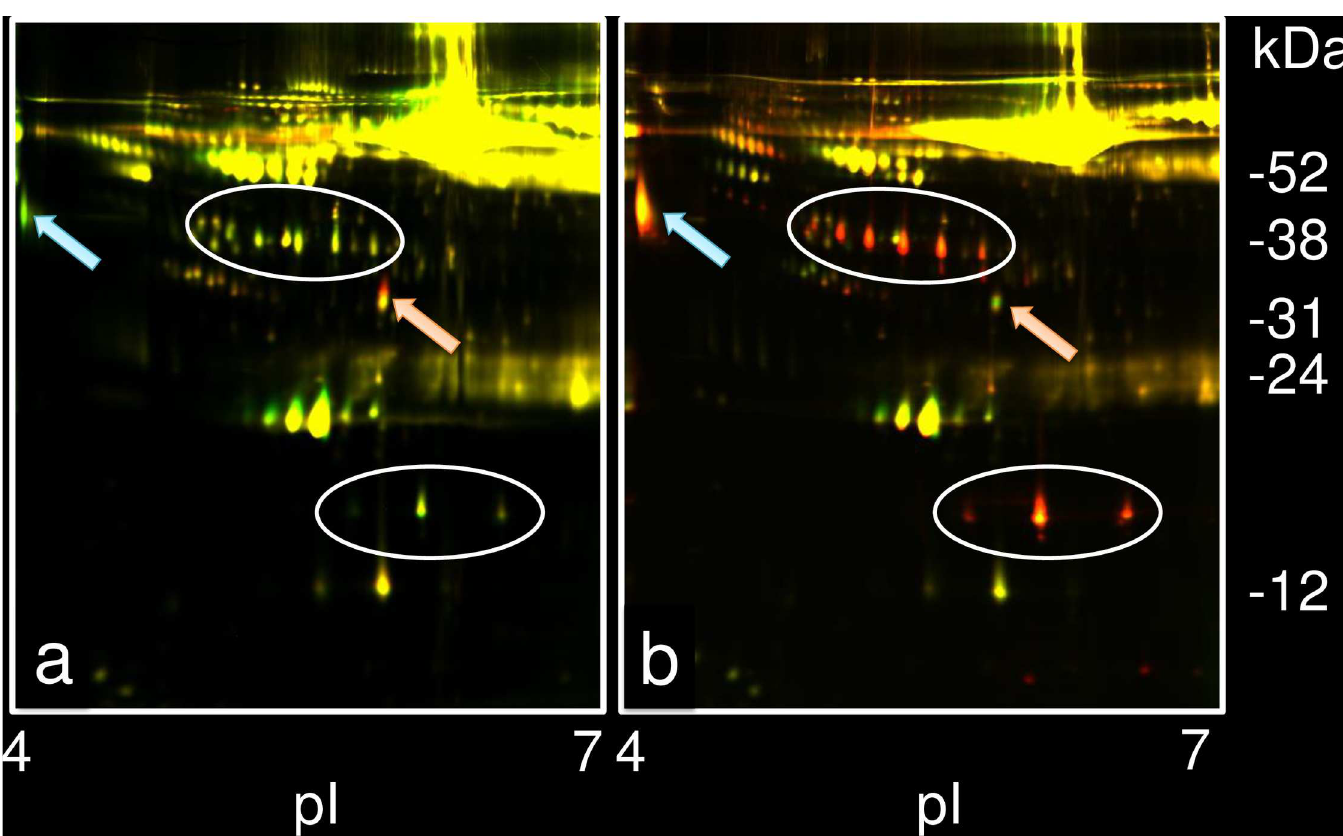
Fig 3. A representative result of 2D DIGE in a diver at 200 msw. (a) Differential expression of plasma proteins in hyperbaricconditionsat 200 msw for 17 h compared with that before SD training in a healthy diver. The red spot indicatedby a pink arrow was located at 32.4 kDa, pI 5.8 (ratio; 2.18). The green spot indicatedby a light blue arrow was located at 44.8 kDa, pI 4.0 (ratio;-1.32). (b) Differential expression of plasma proteins during the decompression phase at 100 msw and pre-SD training in the same diver. The 32.4-kDa spot decreased to about the same level, indicatedby a pink arrow (ratio; 1.25). The expressionof the 44.8-kDa protein increased(ratio; 2.73), indicated by light blue arrow. High expression of Hp is indicatedby the spots circled in